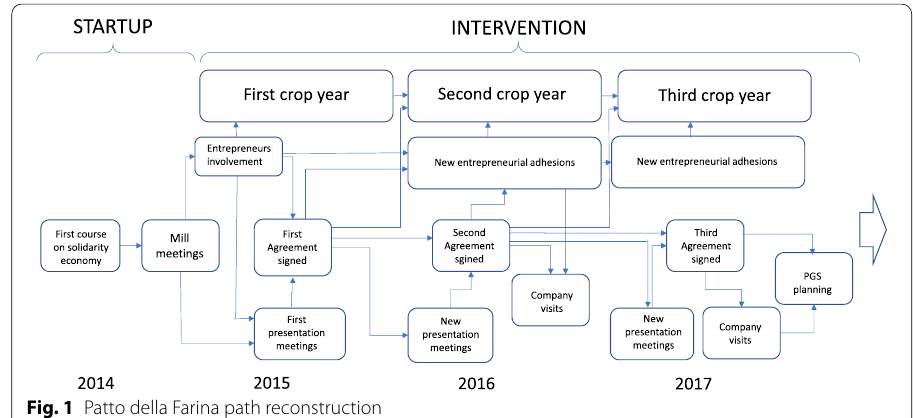
Fig. 1 Patto della Farina path